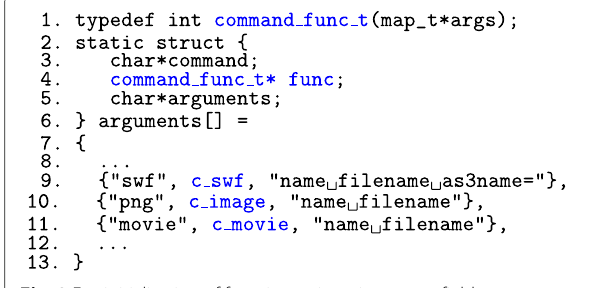
Fig. 3 E.g. initialization of function pointer in a struct